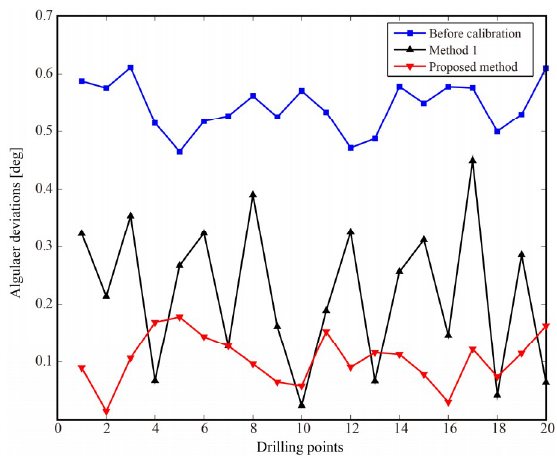
Figure 12. The angular deviation after experimental calibration by the methods. Table 8. The statistics of the angular deviation after experimental calibration by the methods. Max. [deg] Mean [deg] Std. [deg] Before 0.6113 0.5434 0.0432 Method 1 0.4487 0.2192 0.1270 Proposed method 0.1780 0.1048 0.0443